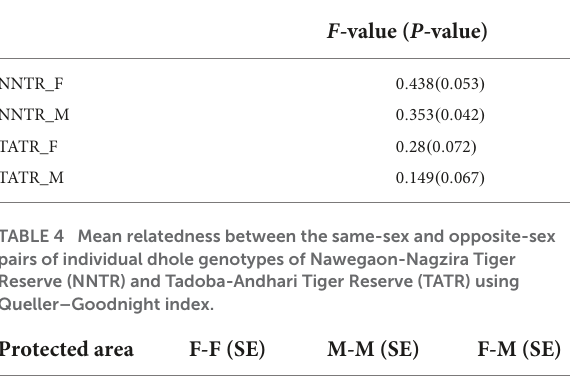
TABLE 3 Test for the difference between sexes in the F -values within Nawegaon-Nagzira Tiger Reserve (NNTR) and Tadoba-Andhari Tiger Reserve (TATR) populations with significant values ( P < 0.05).